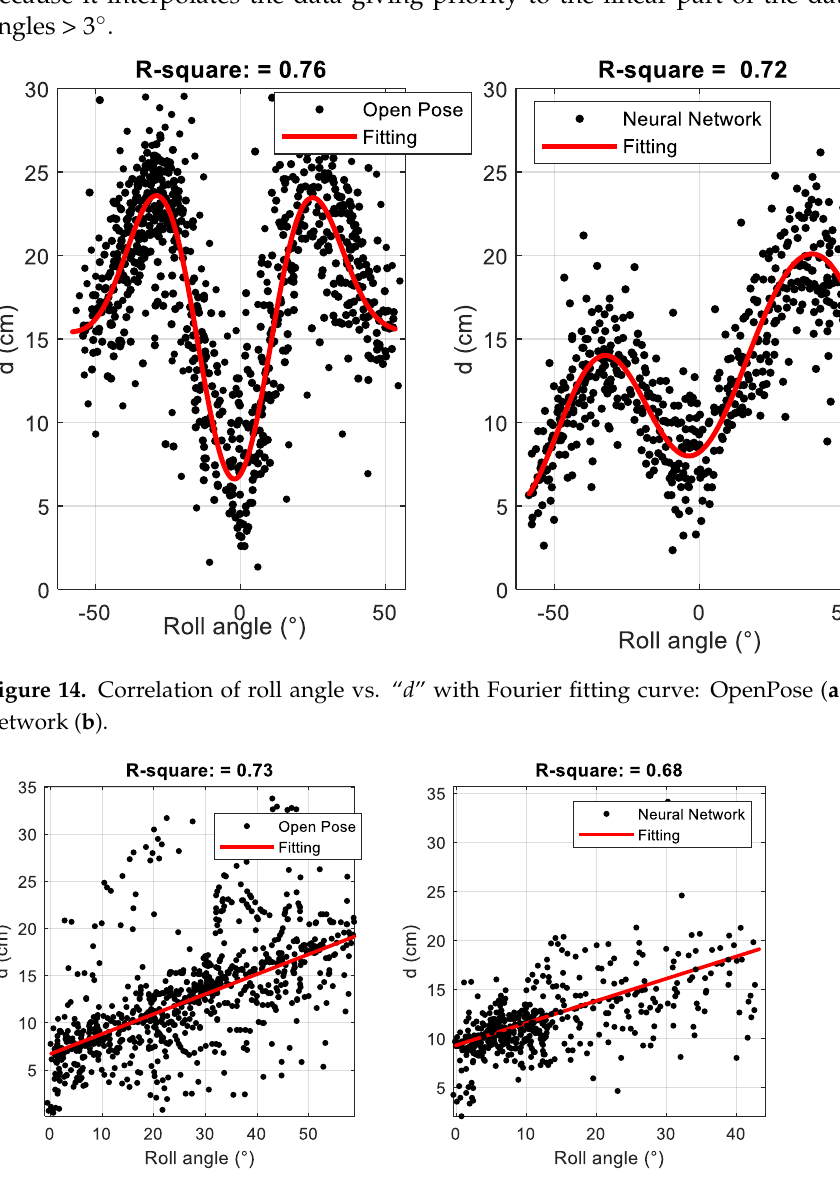
Figure 15. Linear regression line: OpenPose ( on left ) and neural network ( on right ).